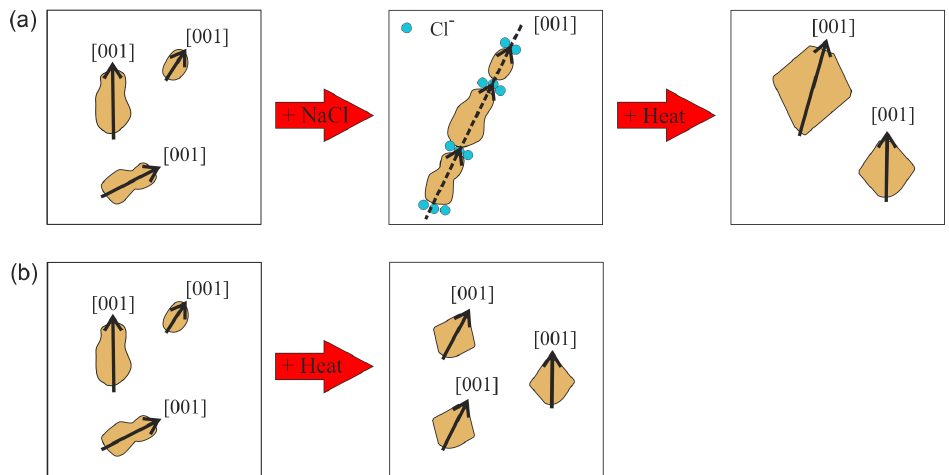
Figure 13. Model of aggregation and crystal growth. ( a ) Oriented alignment assisted by Cl − ions attached to (001) surfaces of the particles which lead to linear chains, like observed in the TEM images of the sample with 2.5 mM NaCl, followed by enhanced crystal growth during heat treatment. We have not observed if any ions are sitting on the (001) particles surfaces so the model is speculative; ( b ) Crystal growth of the heated samples without salt.